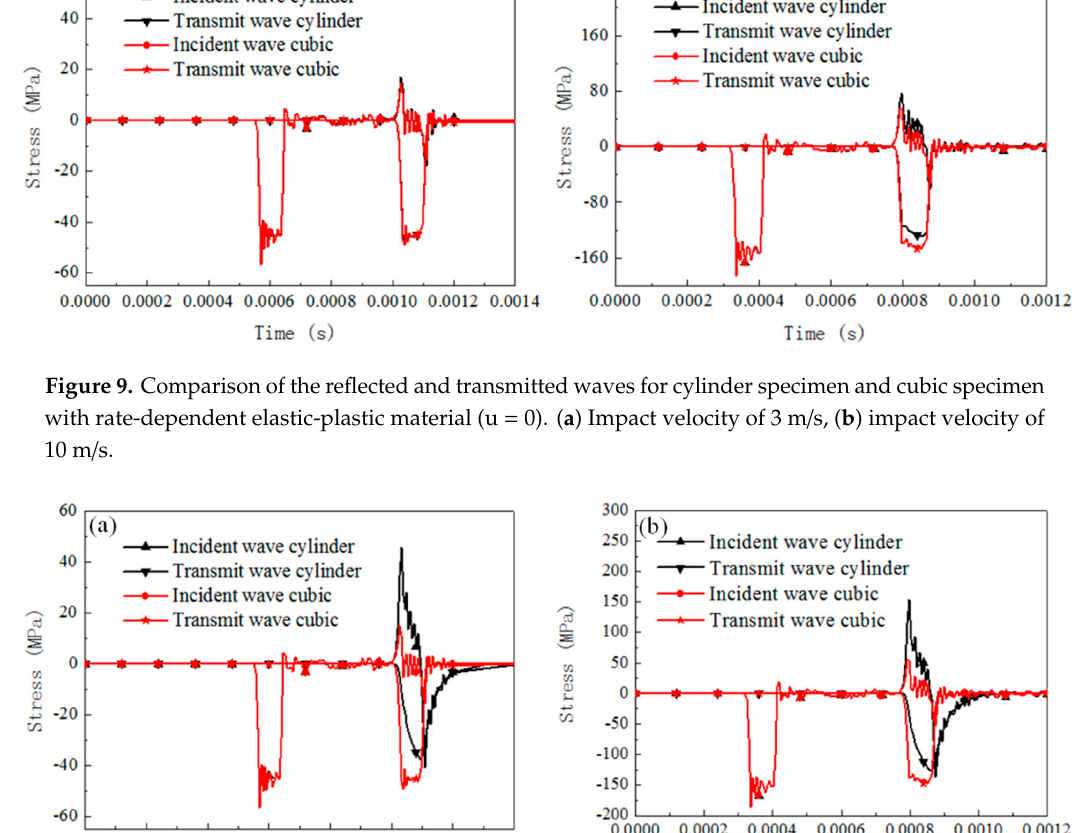
Figure 11. Typical compression deformation of cuboid, equivalent strain distribution at the end of compression. 5.2.2. Influence of Specimen Configuration on SHPB Dynamic Results The dynamic response of the cylinder specimen with different slenderness under SHPB compression for rate-independent material, rate-dependent elastic-plastic material, and rate- dependent viscoelasticity material are numerically analyzed by considering 0.5, 1, 1.5. The contact condition is set frictionless. The results of the stress pulses of the incident and transmitted bars are presented in Figures 12–14. For rate-independent materials, the duration of the waves is not affected by the specimen slenderness regardless of the impact velocities. When the impact velocity is 3 m/s, the transmit stress level of the specimen first increases then decreases with the specimen slenderness increasing. The maximum stress value is 31% higher than the minimum stress value. When the impact velocity is 10 m/s, the transmit stress level shows a similar trend and the ratio of increment is 44%. For rate- dependent elastic plastic materials, the duration of the waves and the transmit stress level are not affected by the specimen slenderness for different impact velocities. For rate-dependent viscoelasticity materials, similar observations as for rate-independent materials are noticed. The duration of the waves is not affected by the specimen slenderness. The transmit stress level of the specimen first increases then decreases with the specimen slenderness increasing. The ratio of increment is 18% for the 3 m/s impact velocity and 17% for the 10 m/s impact velocity. The specimen geometry has a significant effect on the reflected and transmitted wave stress levels for rate-independent materials and rate-dependent viscoelasticity materials, but not for rate- dependent elastic plastic materials. The transmit stress value first increases then decreases with the increasing specimen slenderness.